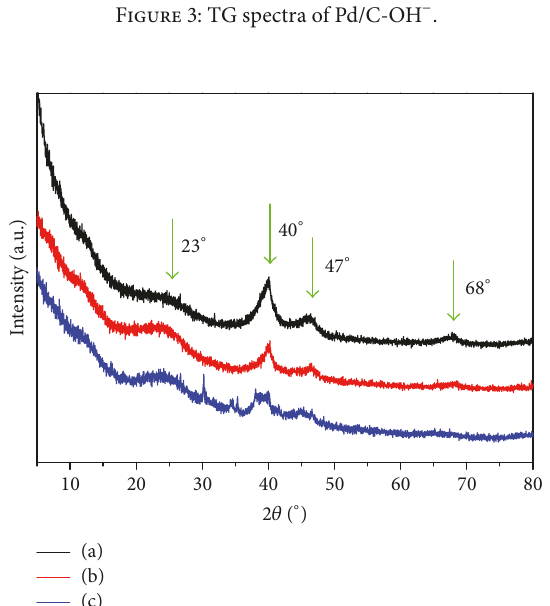
Figure 4: XRD patterns of (a) Pd/C, (b) Pd/C-Cl − , and (c) Pd/C- OH − .